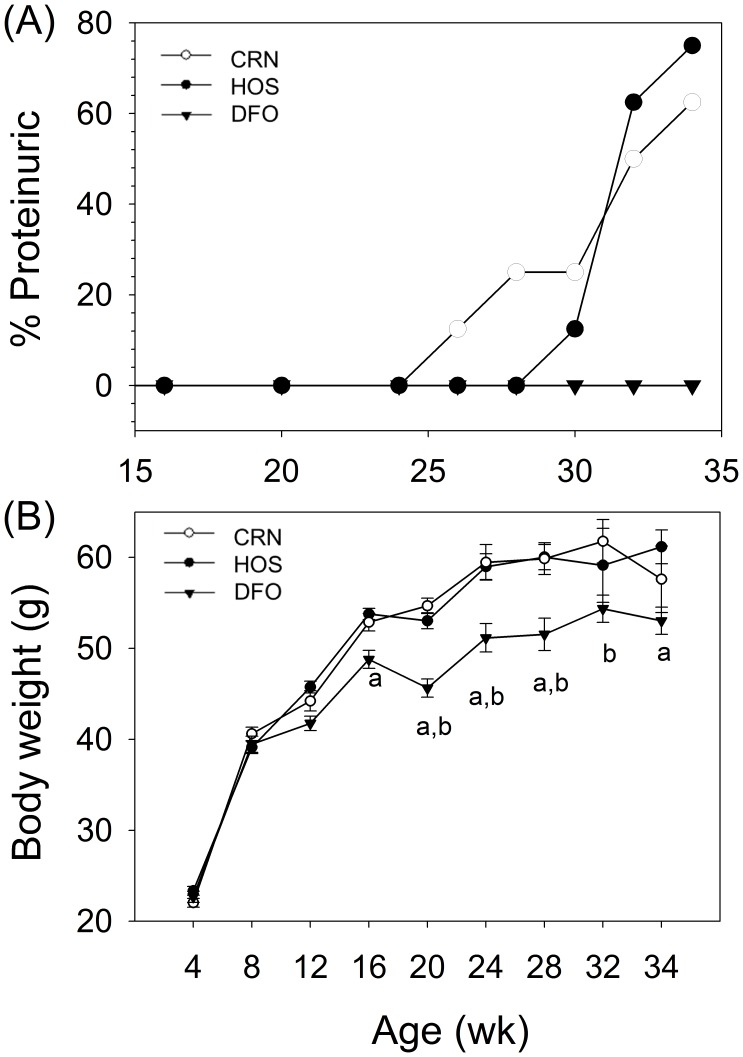
n-3 PUFA consumption prevents proteinuria onset and reduces weight gain.Female NZBWF1/J mice were fed DFO, CRN or HOS diets beginning at 4 wk of age. (A)Urinary protein was assessed using urinalysis reagent strips. Mice exhibiting ≥300 mg/dL were considered positive for proteinuria. (B) Effect of experimental diets on body weight. Values are mean ± SEM (n = 16) until 16 wk of age and n = 8, thereafter Letters a and b indicate body weights of DFO-fed mice differ significantly from those of CRN- and HOS-fed mice, respectively (p<0.05).